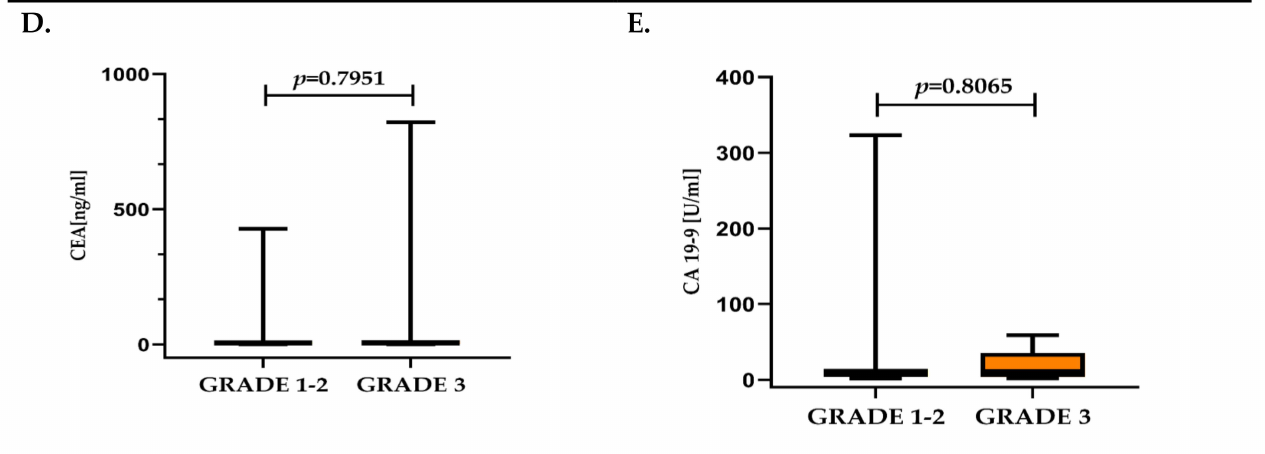
Figure 4. ( A – E ). The concentration of inflammatory response biomarkers (CRP, IL-6, sCD40L) and cancer biomarkers (CEA, CA 19-9) in colorectal cancer patients (CRC) depending on the grade. Table 2. Univariate and multivariate linear regression analysis results for CRP in colorectal cancer patients.